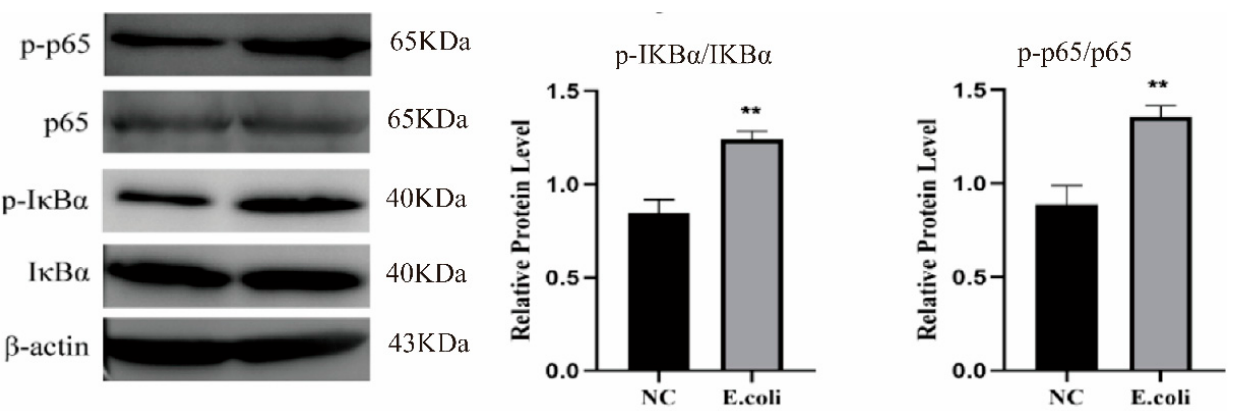
Figure 1. Infusion of Escherichia coli to establish a mouse model of endometritis. ( A , B ), Effects of